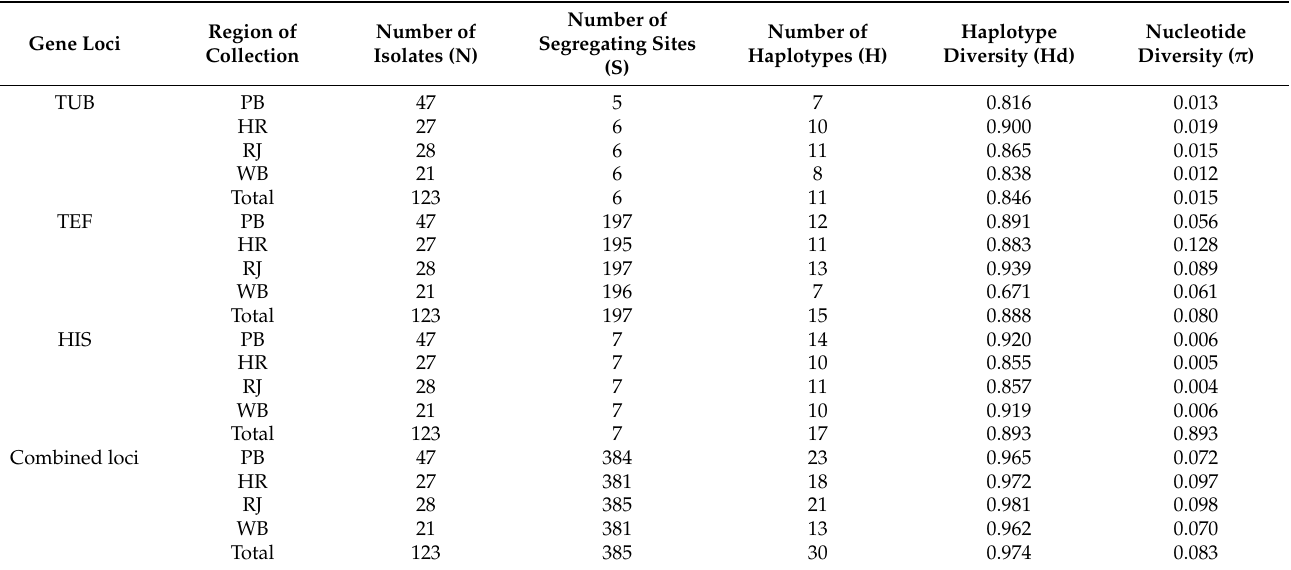
Table 4. DNA polymorphism data for F. graminearum isolates based on beta-tubulin (TUB), translation elongation factor 1 alpha (TEF) and histone (HIS) gene sequence comparisons.